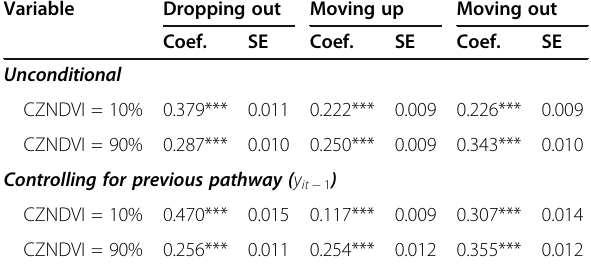
Table 6 The impact of CZNDVI on livelihood pathways Variable Dropping out Moving up Moving out Coef. SE Coef. SE Coef. SE